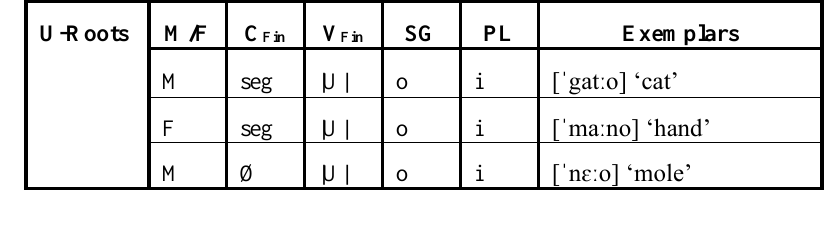
Table 6. Roots with final floating element |A|